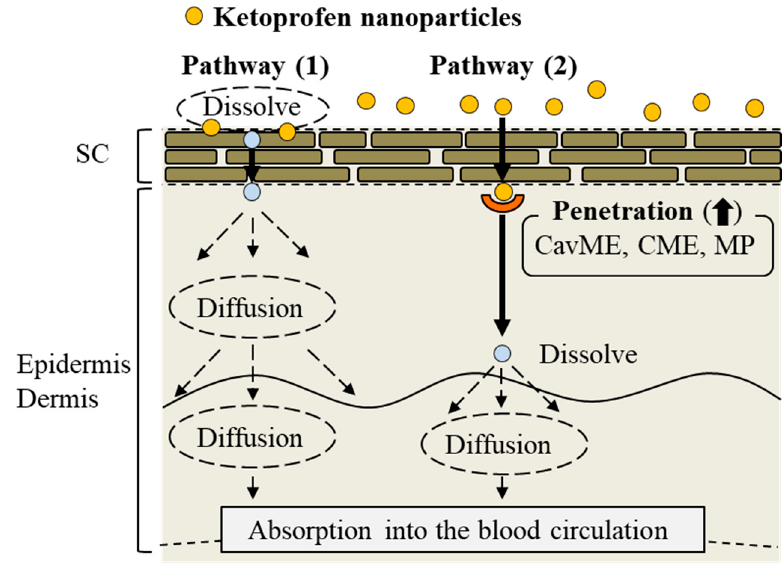
Figure 6. Mechanism for the percutaneous absorption process from the transdermal formulation containing ketoprofen nanoparticles.